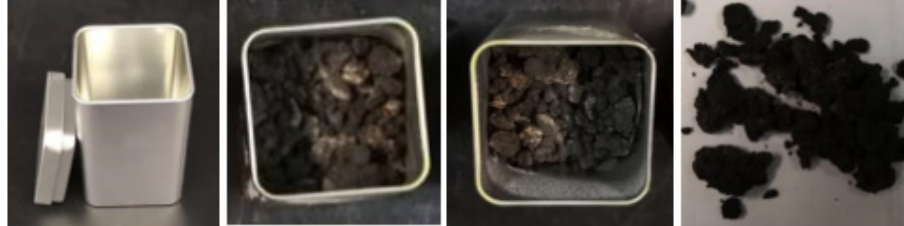
Figure 1. The sewage sludge and biochar samples example. From the left, the crucible, raw SS sample in the crucible, biochar from SS in the crucible, and produced biochar from SS.